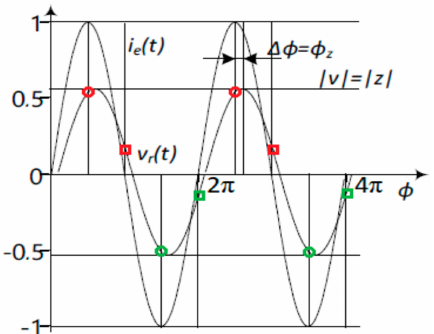
Figure 1. The unity-magnitude excitation current i e (t) with a zero-value initial phase, and the voltage response V r (t) with its magnitude, and phase shift. The normalized magnitudes of current and voltage in relative units given on vertical axis, and the phase on the horizontal axis. The samples related to the real part of the complex response of the i-th period s (i,1) and s (i,3) are designated by orange, and green circles, respectively, and samples corresponding to the imaginary part of the complex response of the i-th period s (i,2) and s (i,4) are designated by orange and green squares respectively.